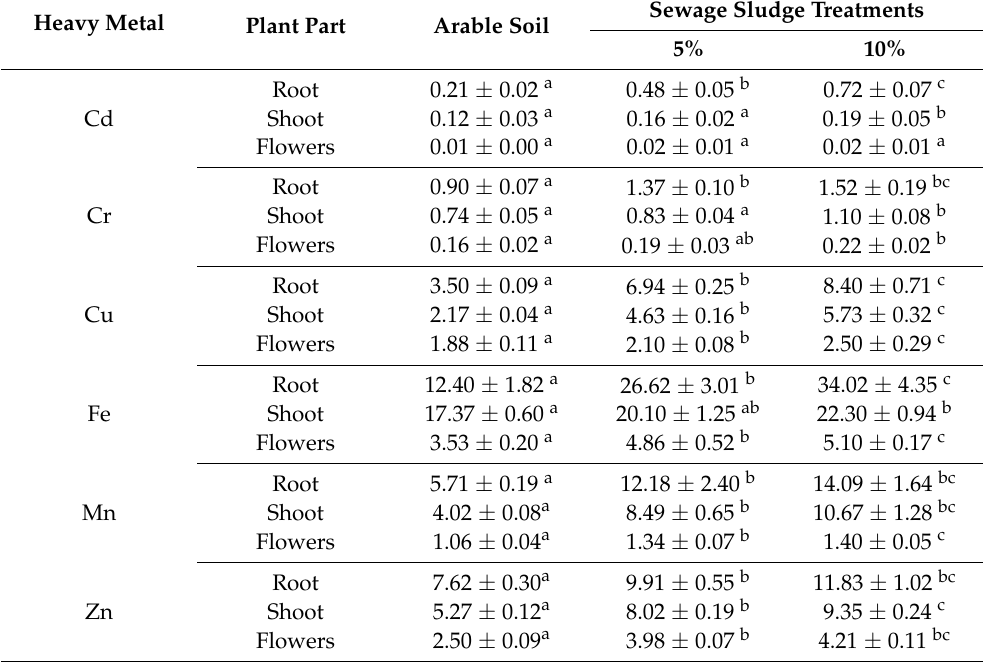
Table 4. Impact of sewage sludge amendment on heavy metal accumulation in different plant parts of cultivated marigold. Heavy